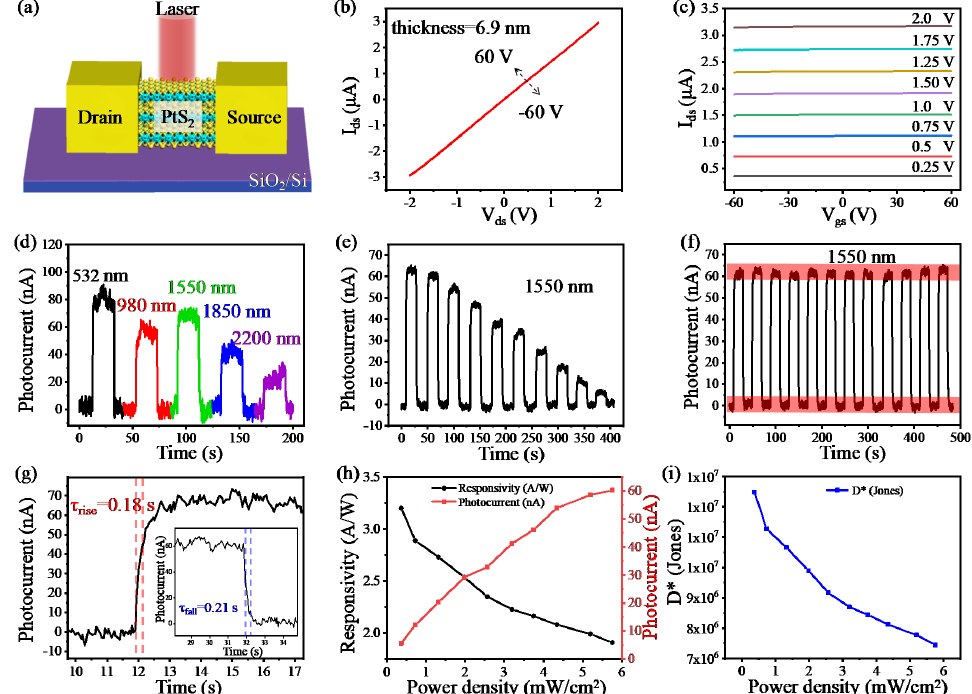
Figure 3. Optoelectrical properties of as-grown PtS 2 films at room temperature. ( a ) Schematic of back gate PtS 2 FETs on SiO 2 /Si substrate. ( b , c ) Output and transfer characteristics of PtS 2 FETs under room temperature and air conditioning. ( d ) I ph of PtS 2 film FETs with V ds = 2 V and various laser wavelengths from 532 nm to 2200 nm. ( e ) Photo-response at wavelength of 1550 nm with power density ranging from 0.01 to 0.18 µ W. ( f ) The I ph response to on/off laser illumination at 1550 nm. ( g ) The response time of PtS 2 FETs at 1550 nm. τ rise is the rise time when the net I ph increases from 10% to 90%. τ decay is the decay time when the net I ph decreases from 90% to 10%. ( h , i ) I ph and D * as a function of laser power at 1500 nm,